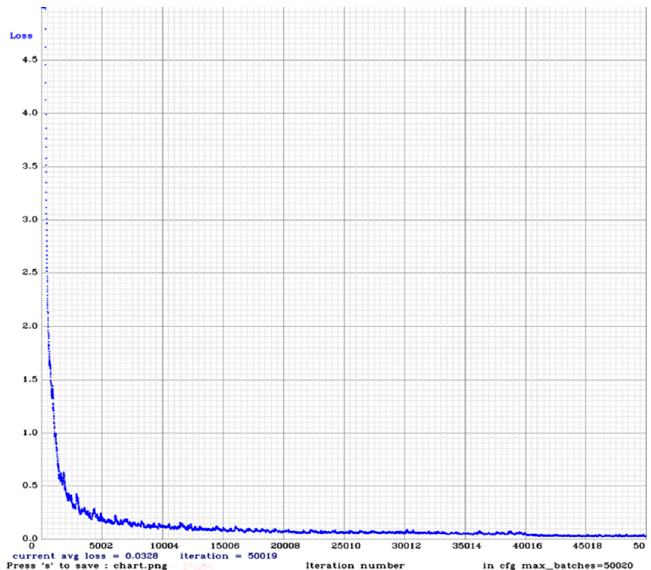
Figure 6. Average loss rate of training data for the strawberry classification model.